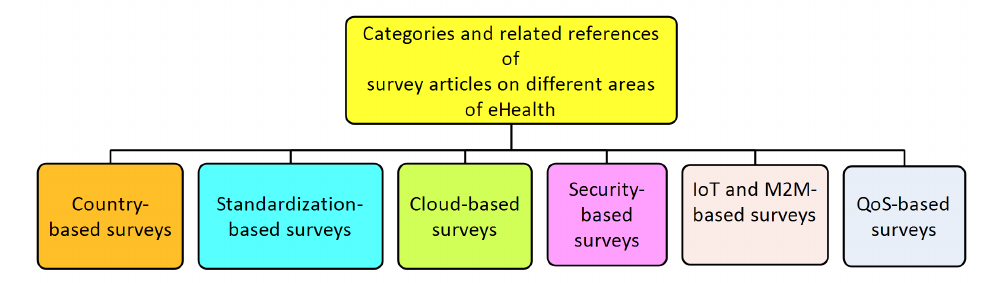
Figure 1. Major components of